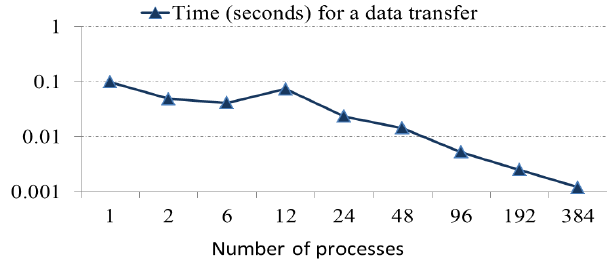
Figure 10. The scaling performance of a data transfer in FGOALS- Fig. 10. The scaling performance of a data transfer in the FGOALS-gc: transferring 19 fields 2 gc: transferring 19 fields on the GAMIL2 horizontal grid from on the GAMIL2 horizontal grid from the GAMIL2 to the coupler component. 3 GAMIL2 to the coupler component.